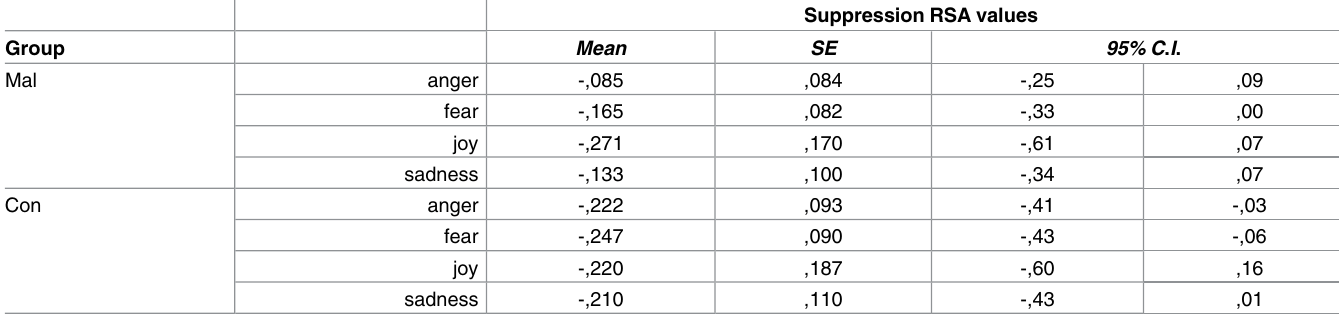
Table 2. Suppression RSA values in response to facial expressions of emotions of Mal and Con